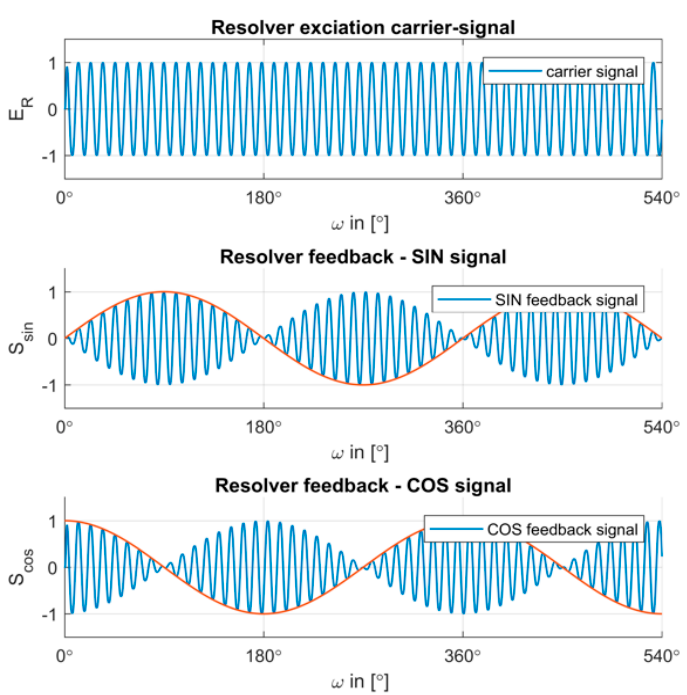
Figure 4. Resolver signals (carrier and feedback signals), as well as the desired envelope feedback signals [2].